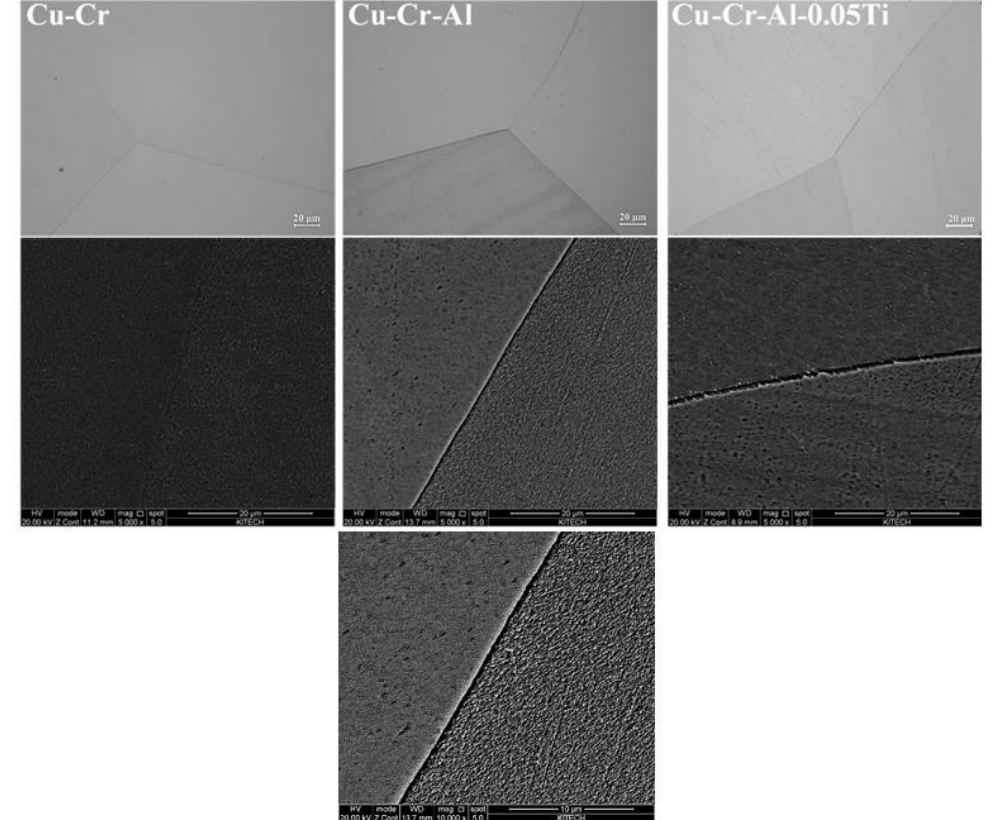
Figure 4. Microstructures of Cu-Cr alloys after solid solution treatment.